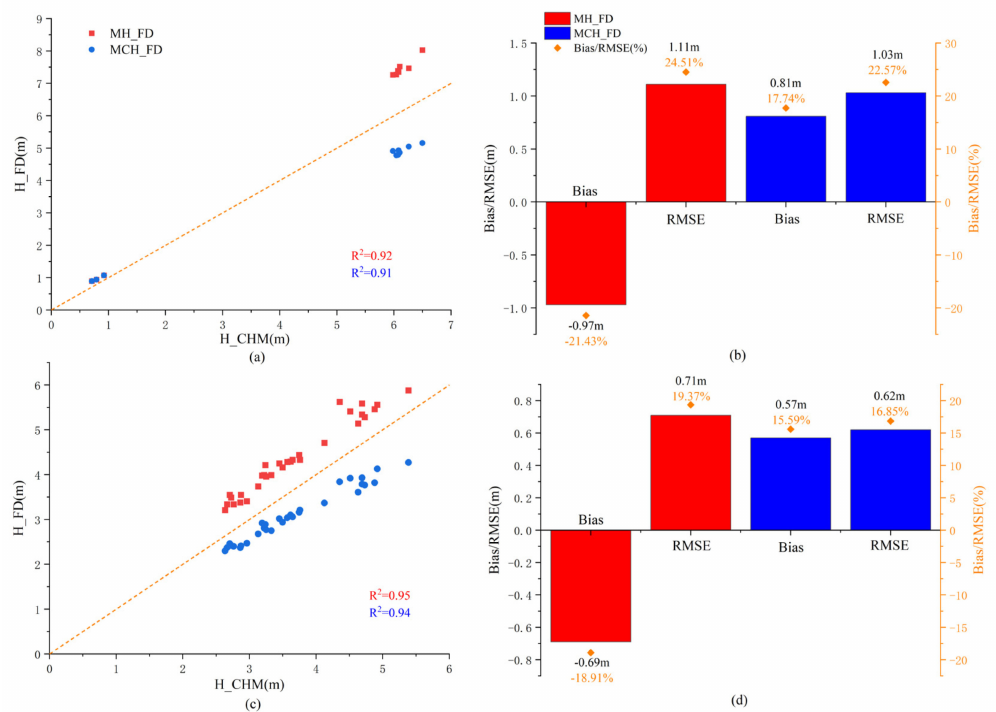
Figure 8. Accuracy assessment of the canopy height: ( a ) Scatter diagram of the H_CHM and H_FD in plots; ( b ) bias, relative bias, RMSE, and relative RMSE of the MH_FD, MCH_FD, and H_CHM in plots; ( c ) scatter diagram of the H_CHM and H_FD; ( d ) bias, relative bias, RMSE, and relative RMSE of the MH_FD, MCH_FD, and H_CHM in individual